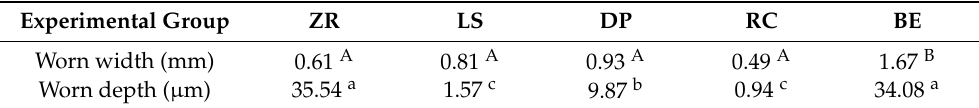
Table 4. Median of worn depth and width of the substrate specimens.